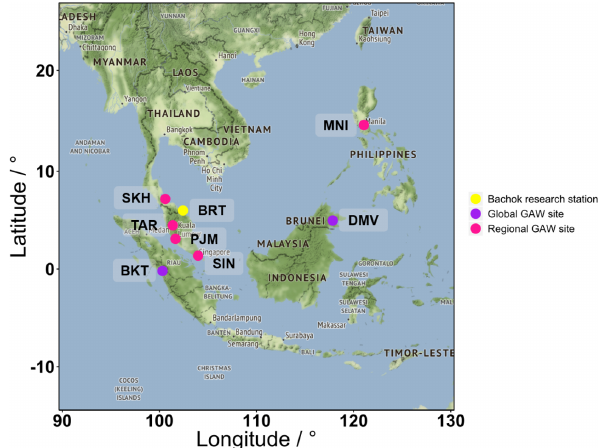
Figure 1. Location of the Bachok research station (BRT) and the global and regional GAW sites in the Maritime Continent: Danum Valley in Malaysia (DMV), Bukit Kototabang in Indonesia (BKT), Manila in Philippines (MNI), Songkhla in Thailand (SKH), Tanah Rata in Malaysia (TAR), Petaling Jaya in Malaysia (PJM) and Sin- gapore (SIN) (GAW-SIS,